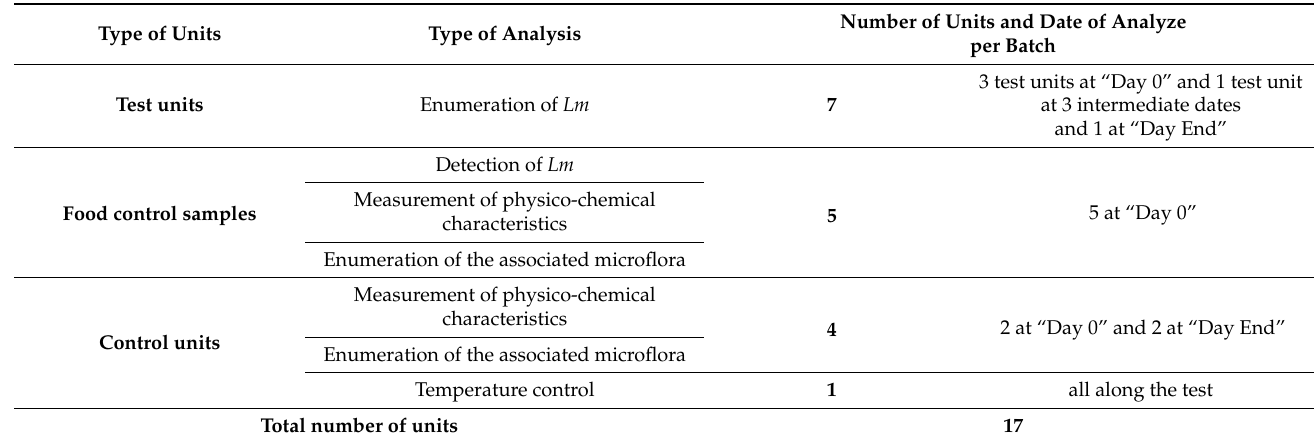
Table 1. Total number of units used for the challenge test assessing the growth potential in Anthotyros cheese, “EURL Lm TGD”